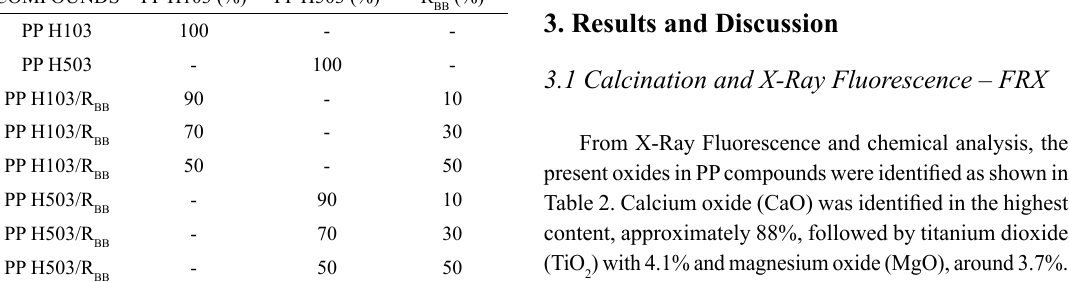
Table 2. Chemical analysis performed by X-ray fluorescence of R